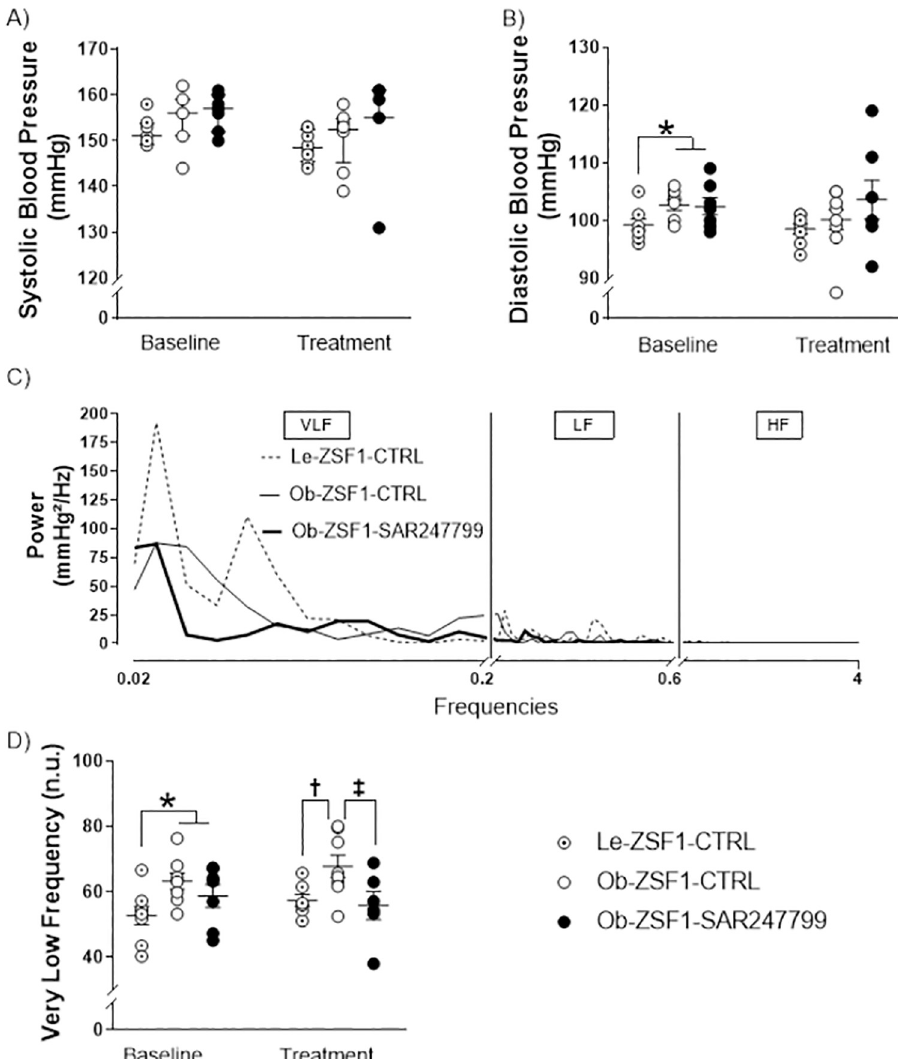
Fig 5. Blood pressure and blood pressure variability after 4 weeks of treatment in adult animals. A) systolic blood pressure (SBP), (B) diastolic blood pressure, (C) representative spectra of systolic blood pressure variability showing very low frequency (VLF), low frequency (LF) and high frequency (HF) bands. (D) very low frequency (n.u.) bands from spectral analysis of SBP variability. Data presented as mean ± SEM, except SBP who is presented as median ± IQR. � p < 0.05, �� p < 0.01: p-values obtained to compare Le-ZSF1-CTRL to Ob-ZSF1 (Ob-ZSF1-CTRL and Ob-ZSF1-SAR247799 pooled) using a Student t-test. A Student t-test was also performed to compare Ob-ZSF1-CTRL to Ob-ZSF1-SAR247799 at baseline. No significant difference was observed between the two randomized groups at baseline for any of the parameters. † p < 0.05: p-values obtained to compare Le-ZSF1-CTRL to Ob-ZSF1-CTRL using a Student t-test. ‡ p < 0.05: p-values obtained from the comparison between Ob-ZSF1-CTRL and Ob-ZSF1-SAR247799 using a Student t-test except for SBP for which a Wilcoxon test was performed. For adult animals, Le-ZSF1-CTRL N = 8, Ob-ZSF1-CTRL N = 8 and Ob-ZSF1-SAR247799 N = 7; N = number of rats. The lower number of n values is due to technical issue in telemetry data